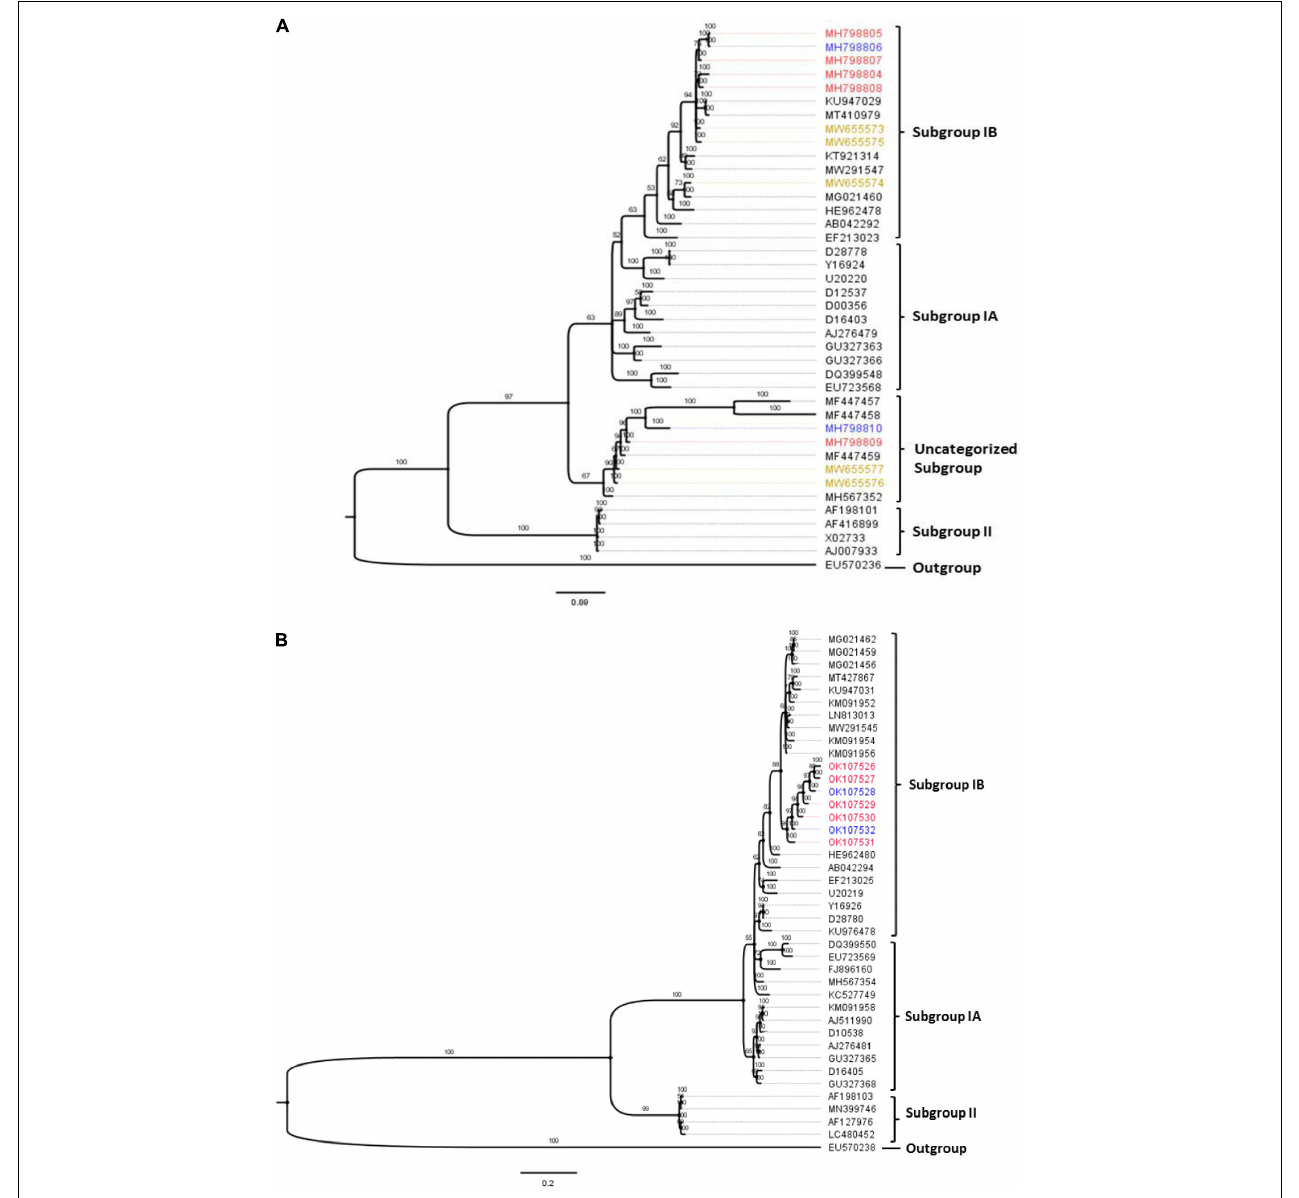
FIGURE 4 | Bayesian phylogenetic analyses of CMV obtained from three hosts in Nigeria, with selected reference worldwide CMV strains. (A) Partial RNA1 genome. (B) Complete CP gene fragment. The trees were rooted using an isolate of peanut stunt virus strain P (accession numbers EU570236 and EU570238 for RNA1 and CP genes, respectively). The numbers above tree branches represent Bayesian inference posterior probability. Sequences obtained from this study were from tomato (blue), pepper (red) and watermelon